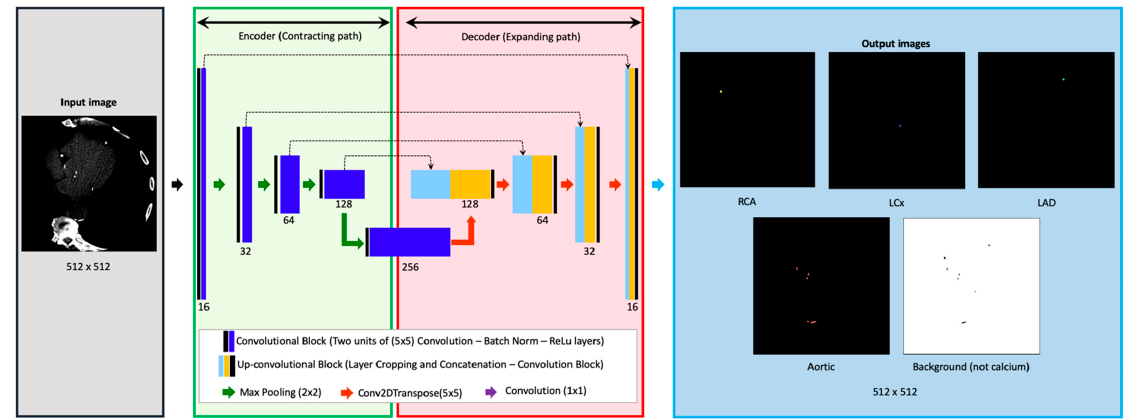
Figure 2. The deep learning model architecture. An input image of 512 × 512 is fed as input to the model (gray). The model used in this study was inspired by U-Net and has two main parts; the encoder (green) and the decoder (red). In the encoder, starting from the initial number of filters as 16, the number of filters was doubled after each subsequent convolutional block followed by a max pooling operation. The decoder part restores the dimensionality of the segmentation mask by concatenating the features from the encoder by application of transposed convolutional operations followed by convolutions, batch normalization and ReLu operations. The segmentation mask of the same resolution is obtained as the model output (blue). Abbreviations: LAD = left anterior descending, LCx = left circumflex, RCA = right coronary artery.